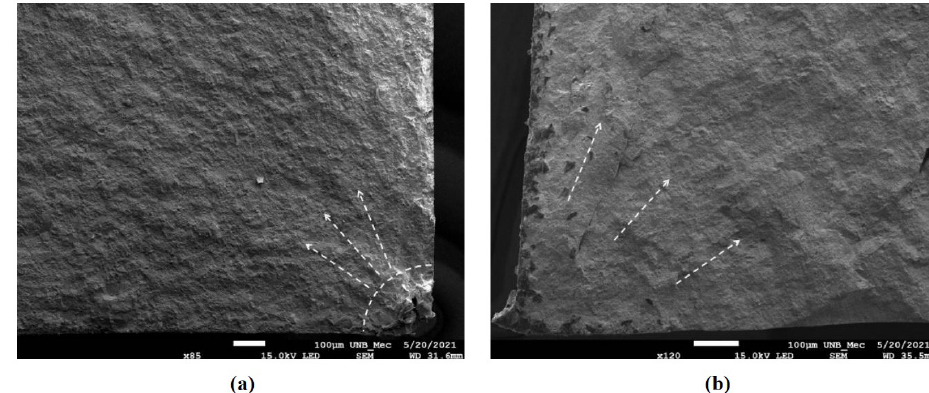
Figure 9. SEM micrographs of the fracture surfaces of ceramic composites after fatigue tests: a) Group A; (b) Group